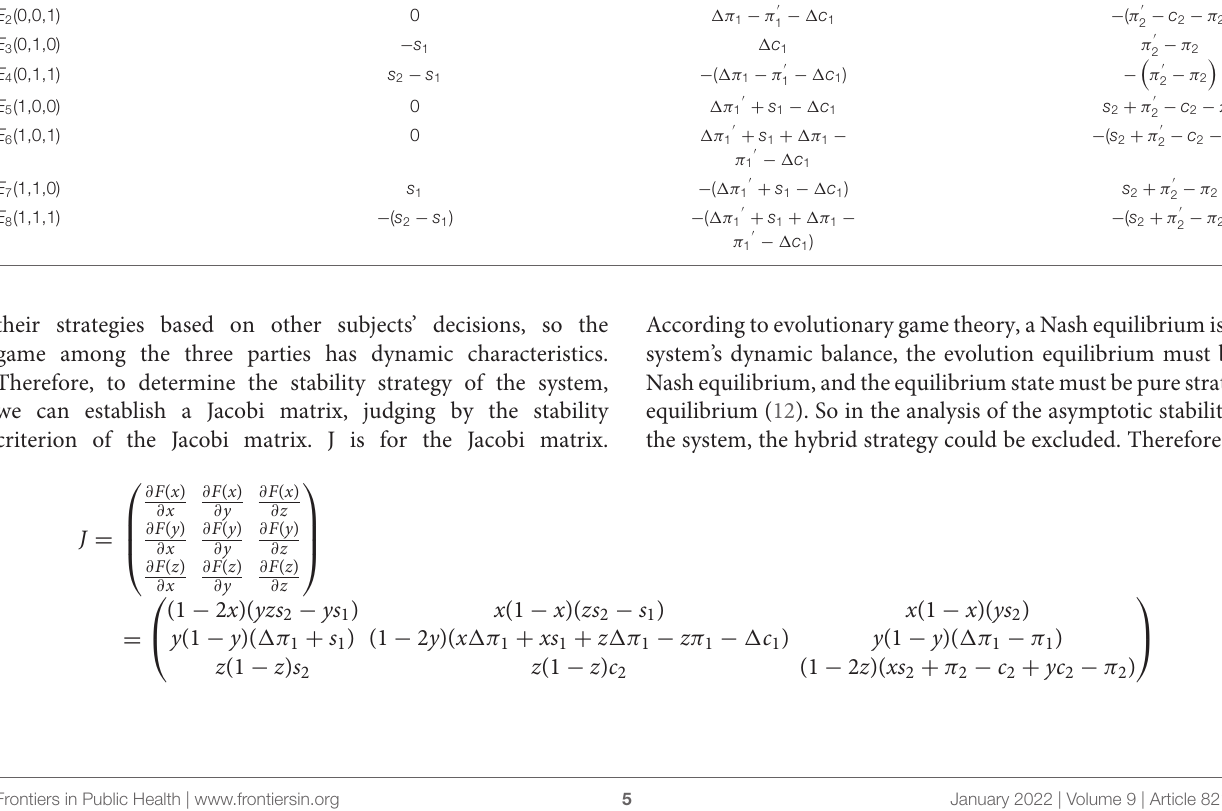
TABLE 2 | Eigenvalues of the matrix corresponding to equilibrium points. Equilibrium points Eigen value Eigen value Eigen value λ